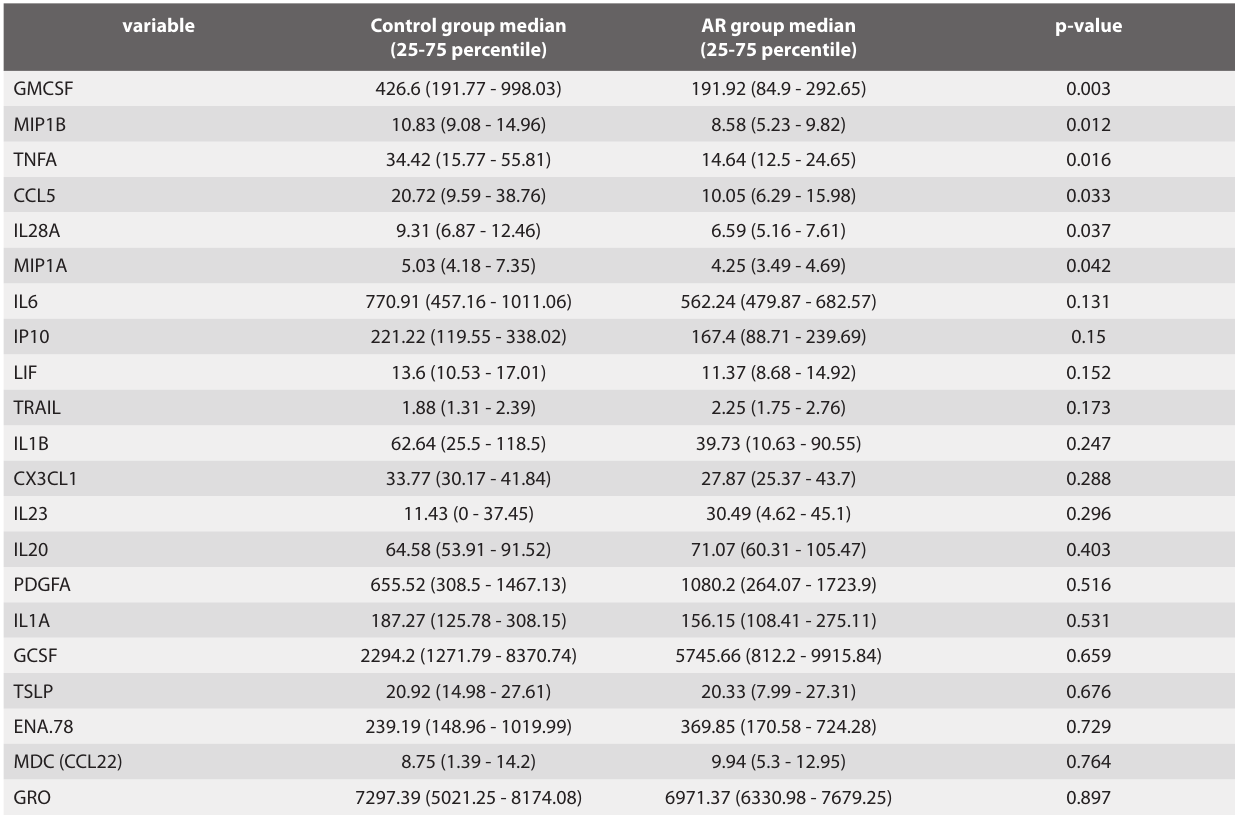
Table 1. The general characteristics of the groups were similar with the exception of the age in AR patients which was higher than in controls (age AR patients Vs controls: 14.96 years old Vs 7.92 years old p-value 0,045).